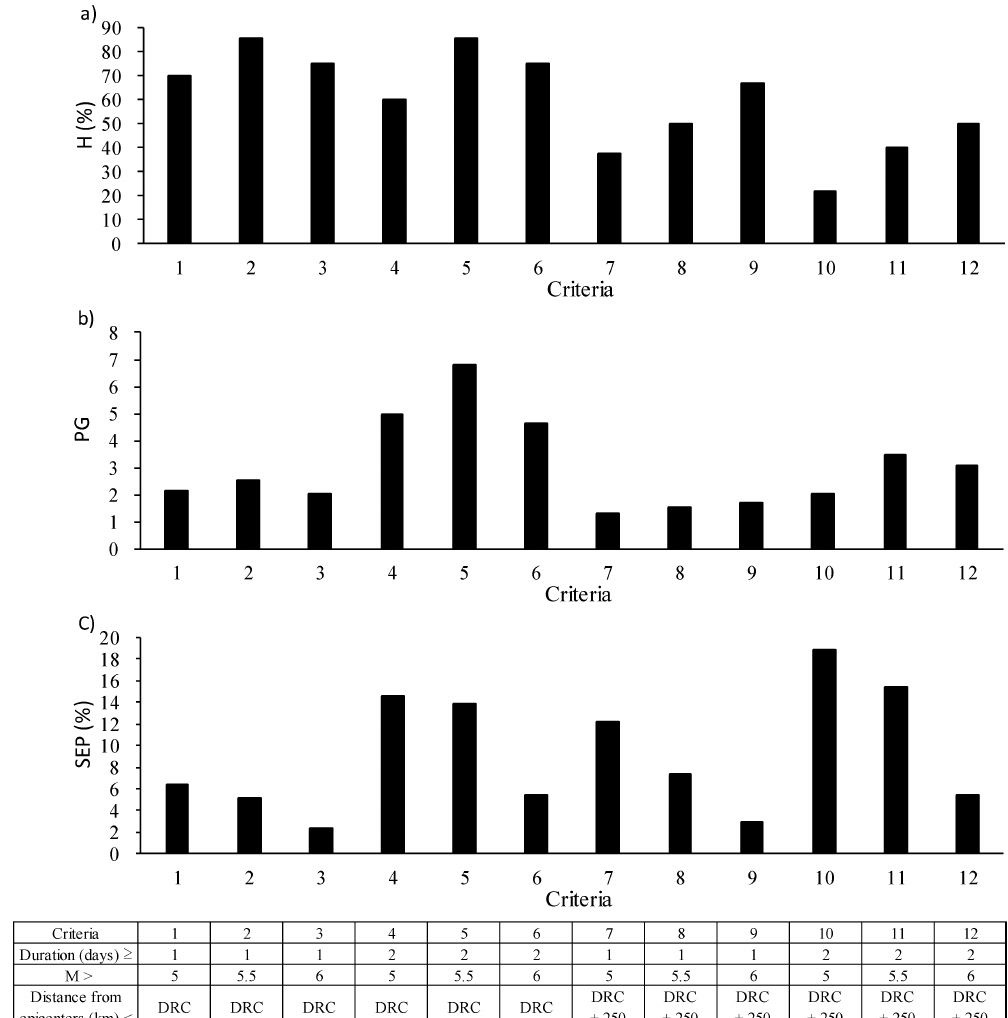
Figure 7. The scores used to estimate the cross-tabulation tables using the twelve criteria. ( a ) shows hit rate (H, %); ( b ) shows probability gain (PG) and ( c ) shows the successful rate of earthquake prediction (SEP, %). The lower table shows the details of the criteria.